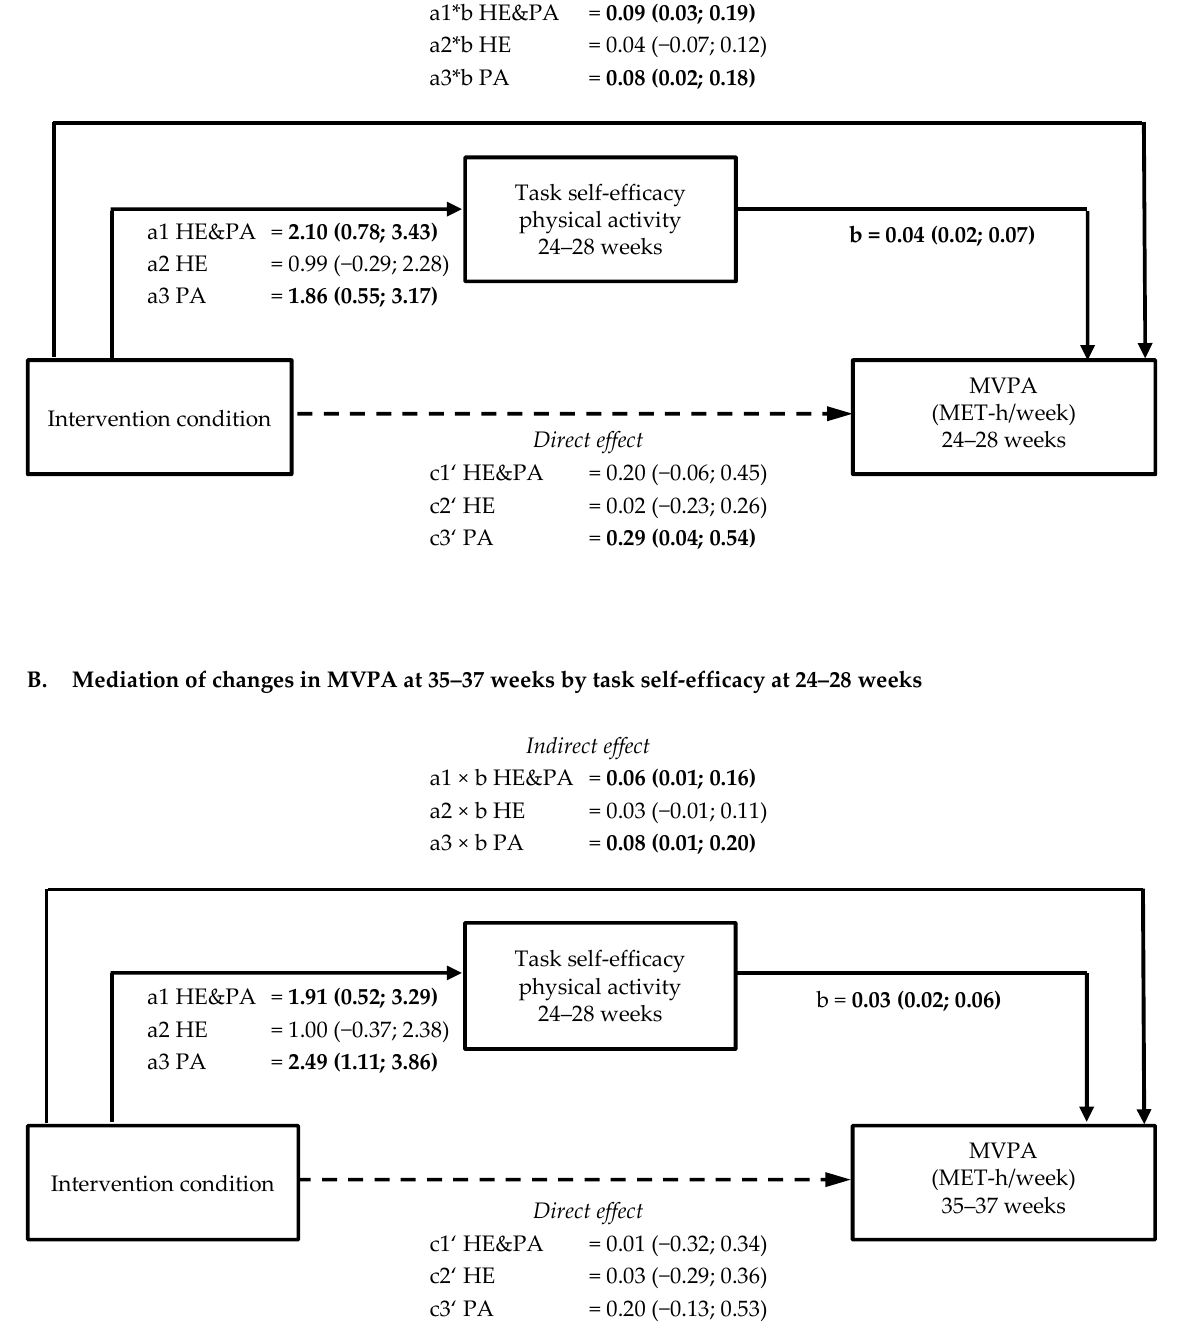
Figure 1. Schematic diagram of the results of mediation by task self-efficacy on moderate-to-vigorous physical activity. Shown are the path coefficients between intervention condition, task self-efficacy at 24–28 weeks, and moderate to vigorous physical activity (MVPA) at 24–28 weeks ( A ) and at 35–37 weeks ( B ). Statistically significant path coefficients are shown in bold and with solid lines. Dashed lines indicated non-significant paths. Indirect effects were calculated as the product of the coefficients of the a and b paths (a × b).